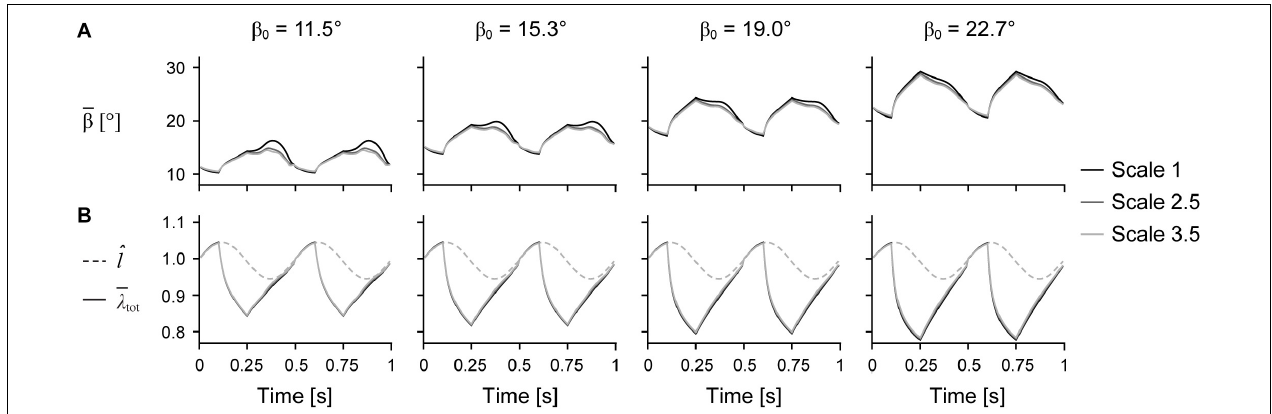
FIGURE 6 | Mean fibre angle and stretch over time. Mean fibre pennation angle relative to the – x axis β (A) and normalised muscle length ˆl and total mean fibre stretch ¯ λ tot (B) over time across initial pennation angles relative to the x -axis β 0 for different scales.